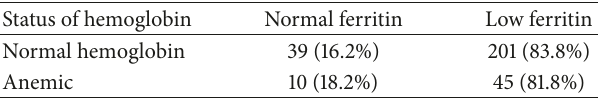
Table 3: Status of ferritin among subjects with anemia and normal